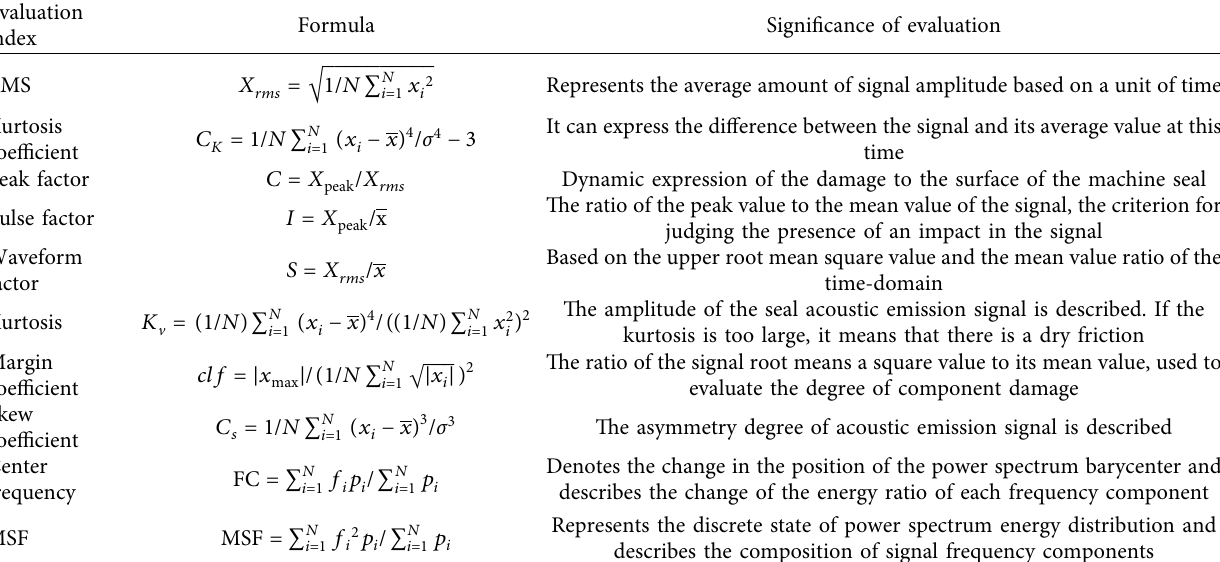
Table 1: Time-domain feature.